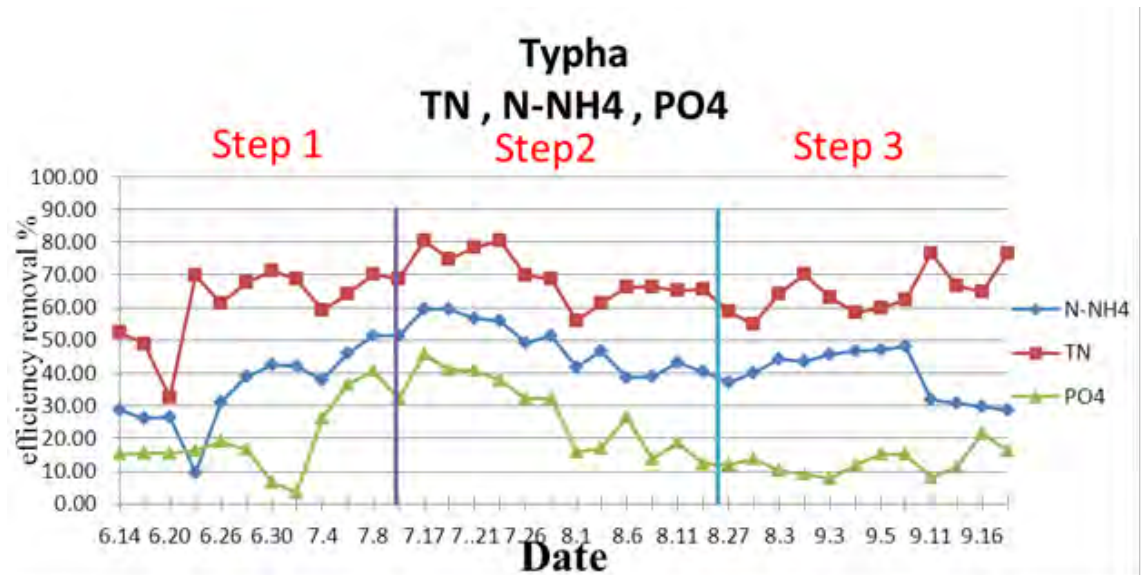
Figure 14. Efficiency removal of TN,N-NH 4 ,PO 4 IN Typha tanks during three surface loads (8,6,4)m 3 /m 2 .h and tow circulation ratios (10%,20%) for each load and for one week time for each different load.